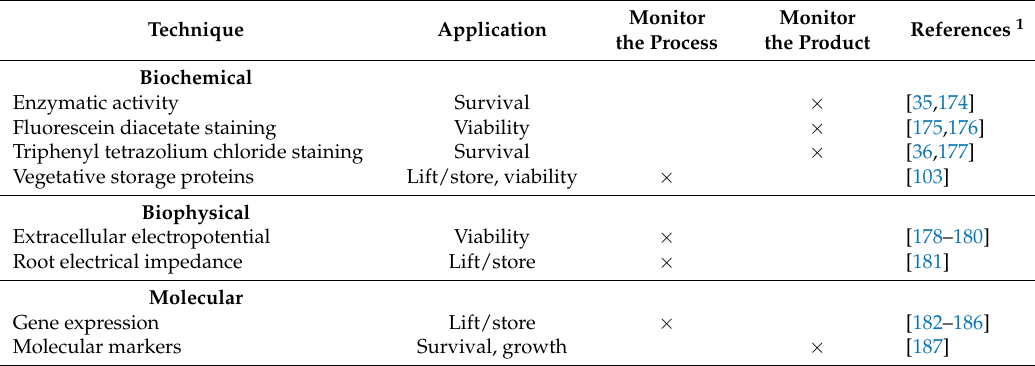
Table 5. Novel measurement techniques at the biochemical, biophysical, and molecular levels, proposed for use in seedling quality-assessment programs to monitor either the process during nursery culture or the product at the end of culture, which were not adopted or were recently reported in the